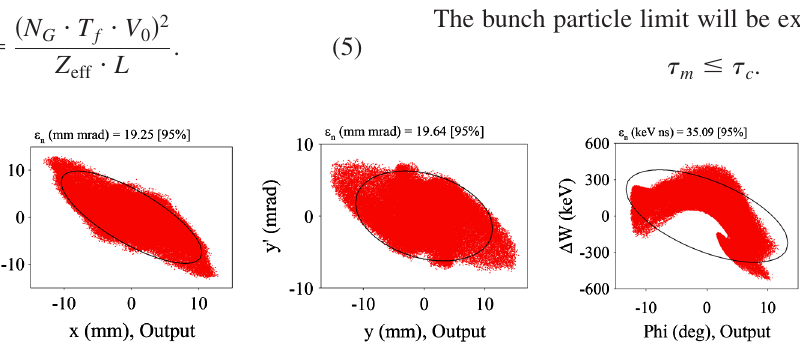
FIG. 27. Output transversal (left and middle) and longitudinal (right) particle distribution at the CH-DTL structure exit where the output energy is 40 MeV. The input particle distributions are shown in Fig. 25 (the red subset).